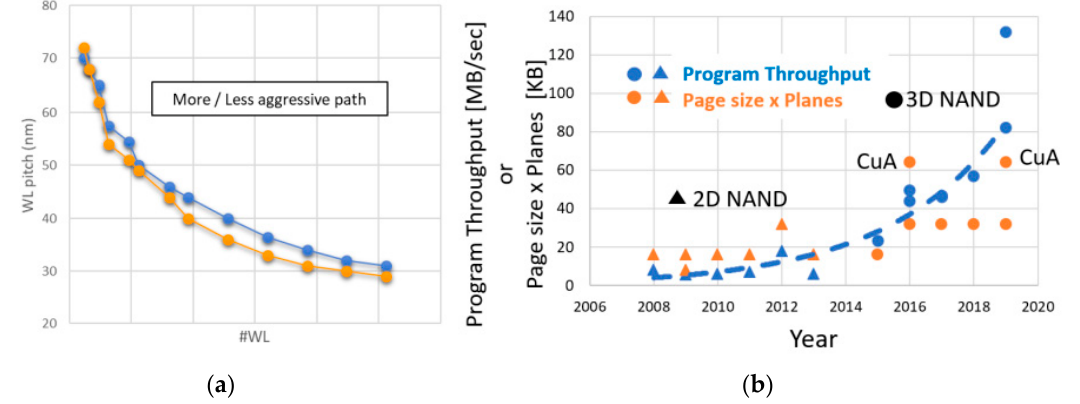
Figure 1. ( a ) WL pitch scaling. Reprinted/adapted with permission from Ref. [10], 2020, IEEE. ( b ) TLC NAND scaling trends of program throughput and parallelism. Reprinted/adapted with permission from Ref. [11], 2020, IEEE.